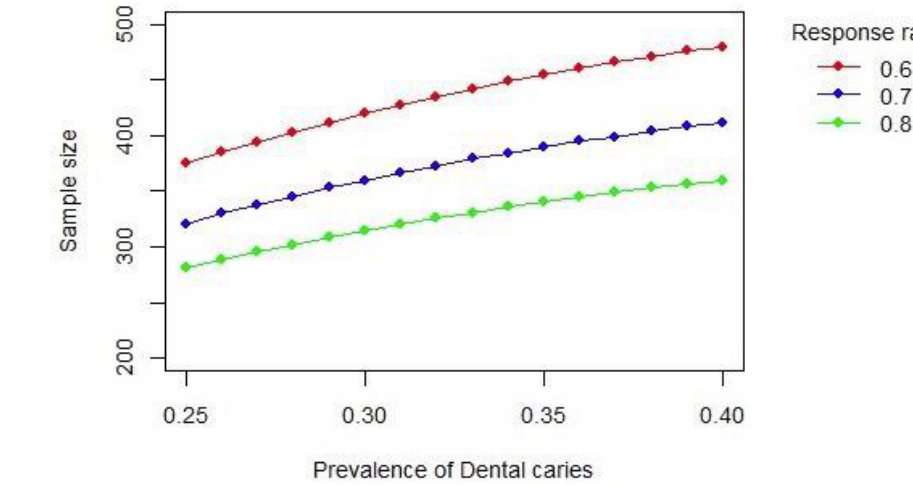
Figure 2. Scenarios for the sample size calculation.